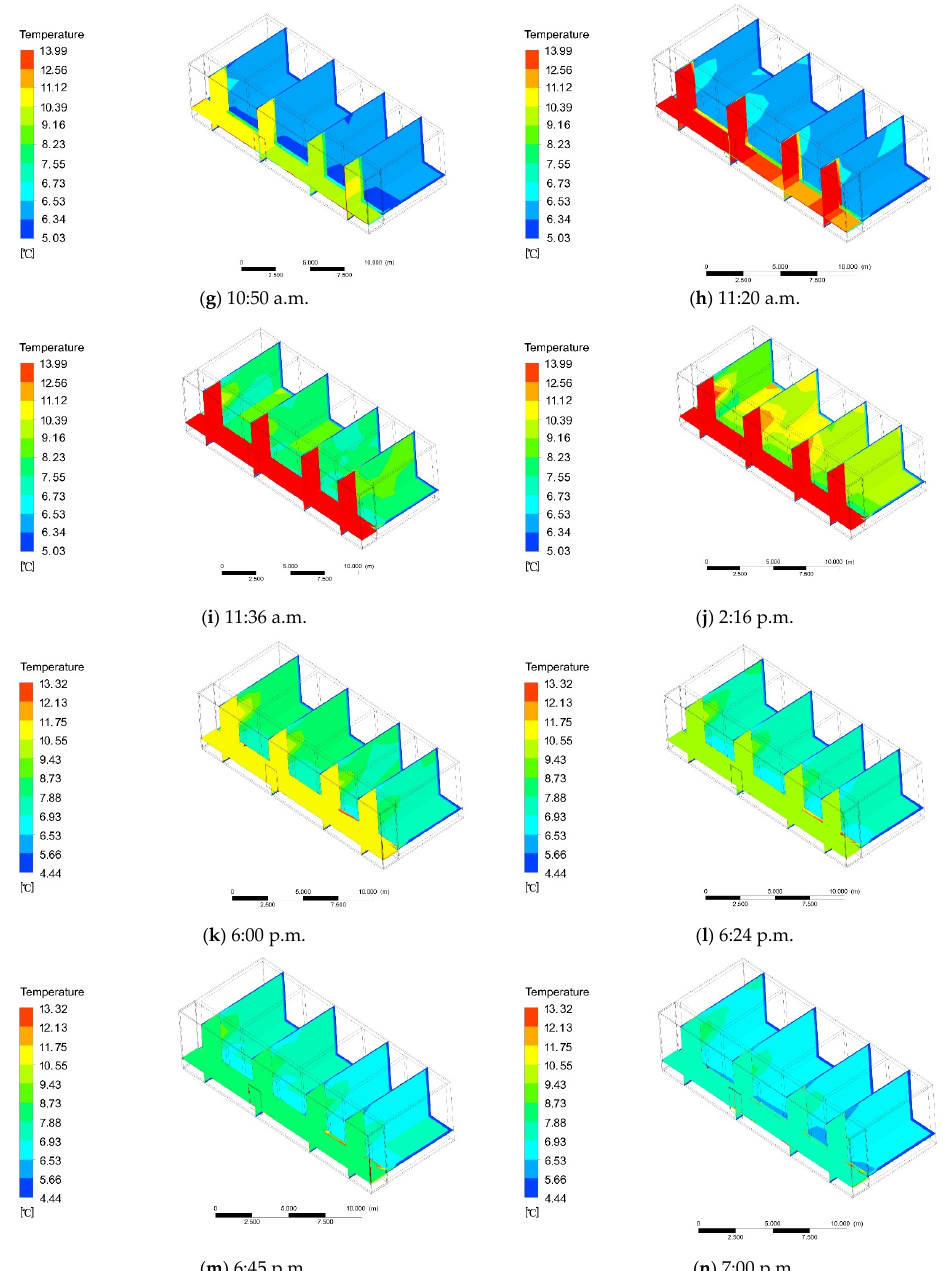
Figure 12. ( a ) At 9:10 a.m. the temperature of the new system (with WSR). ( b ) At 9:10 a.m. the temperature of the new system (with WSR). ( c ) At 9:30 a.m. the temperature of the new system (with WSR). ( d ) At 9:34 a.m. the temperature of the new system (with WSR). ( e ) At 10:10 a.m. the temperature of the new system (with WSR). ( f ) At 10:30 a.m. the temperature of the new system (with WSR). ( g ) At 10:50 a.m. the temperature of the new system (with WSR). ( h ) At 11:20 a.m. the temperature of the new system (with WSR). ( i ) At 11:36 a.m. the temperature of the new system (with WSR). ( j )At 2:16 p.m. the temperature of the new system (with WSR). ( k ) At 6:00 p.m. the temperature of the new system (with WSR). ( l ) At 6:24 p.m. the temperature of the new system (with WSR). ( m ) At 6:45 p.m. the temperature of the new system (with WSR). ( n ) At 7:00 p.m. the temperature of the new system (with